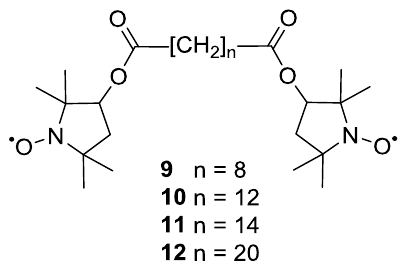
Figure 3. Structure of flexible biradical